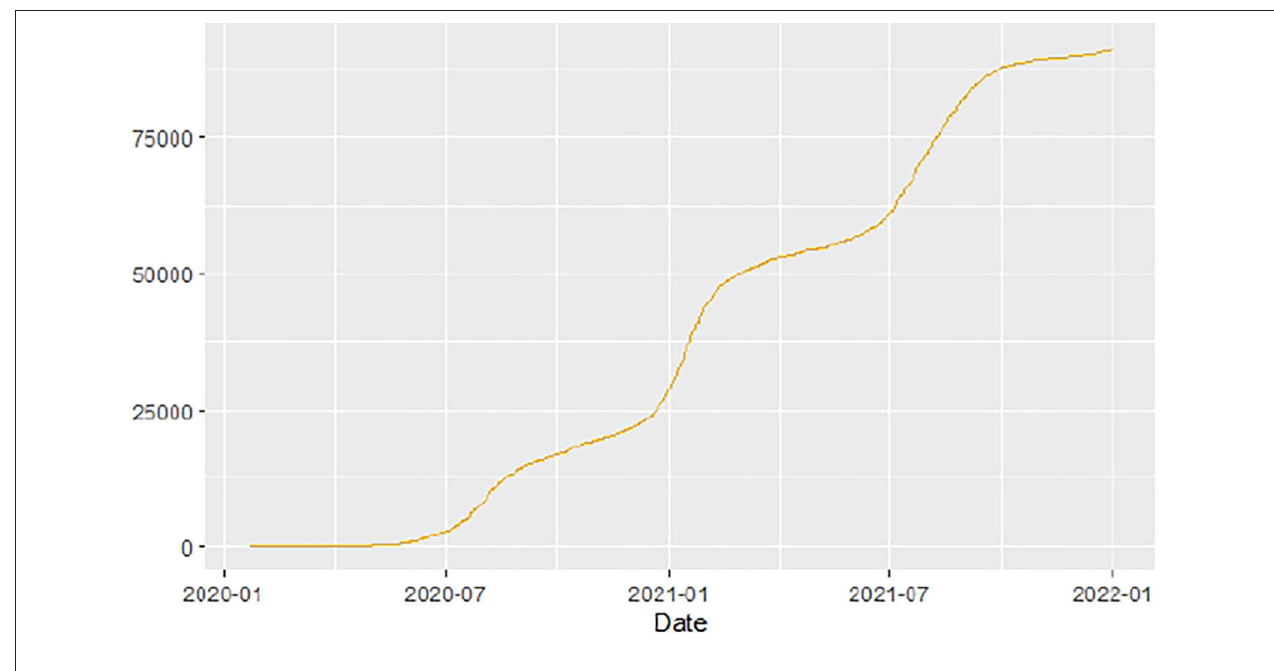
FIGURE 17 | South Africa deaths.